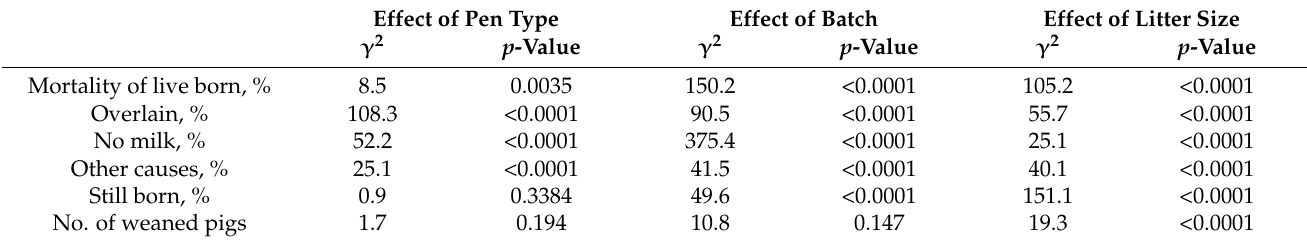
Table 1. Effects of pen type, batch (3 batches with TRAD-traditional pen: n = 61 L and 2 batches with SOWCOMF- SowComfort farrowing pen: n = 57 L) and litter size on piglet mortality in farm 1. Except for stillborn which was given in % of total born piglets and number of weaned pigs, the other variables were given as % of live born piglets.